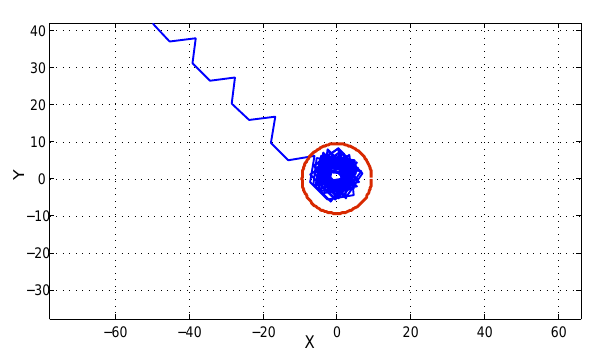
Figure 5: Discrete-time simulation illustrating the con- vergence behavior of Theorem